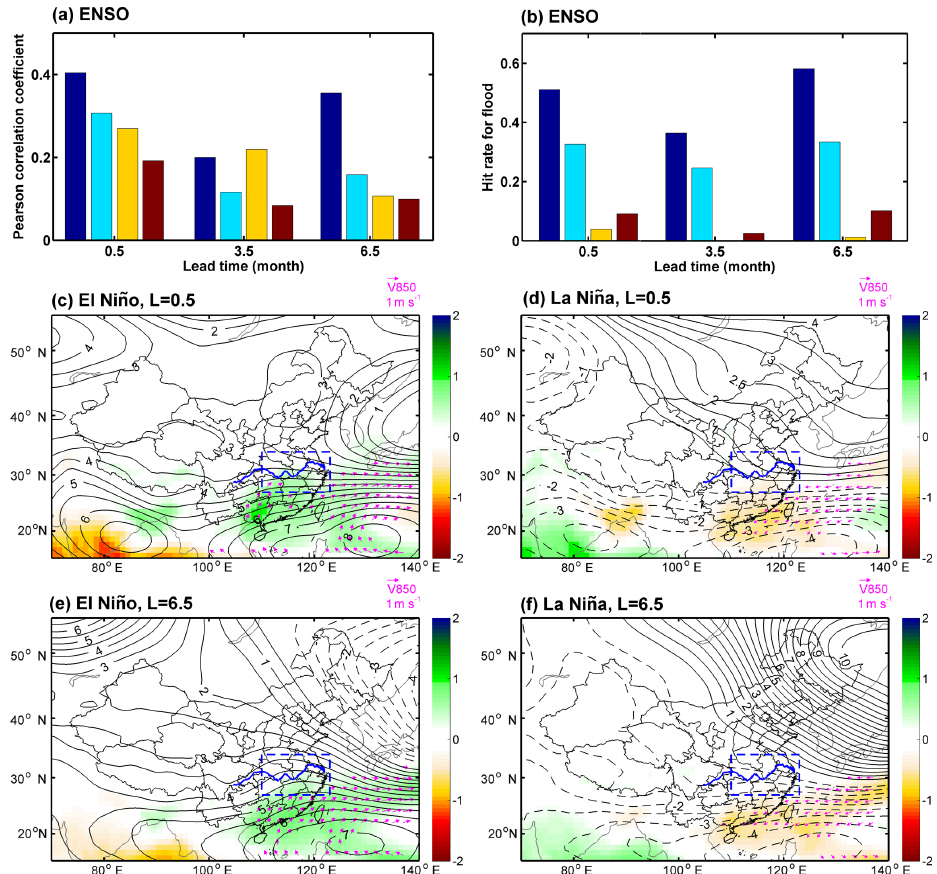
Figure 6. Potential predictability at different lead times in terms of (a) anomaly correlation (AC) for precipitation and moisture, and (b) hit rate (HR) for flood events (>90th percentiles) across the Yangtze River region conditioned on ENSO phases. (c–d) Composites of pre- dicted anomalies of 500hPa geopotential height (contour, gpm) superimposed by 850hPa wind (vectors, ms − 1 ) and moisture flux (shading, gcm − 1 hPa − 1 s − 1 ) at the 0.5-month lead during different ENSO phases. (e–f) The same as (c–d) , but for a 6.5-month lead